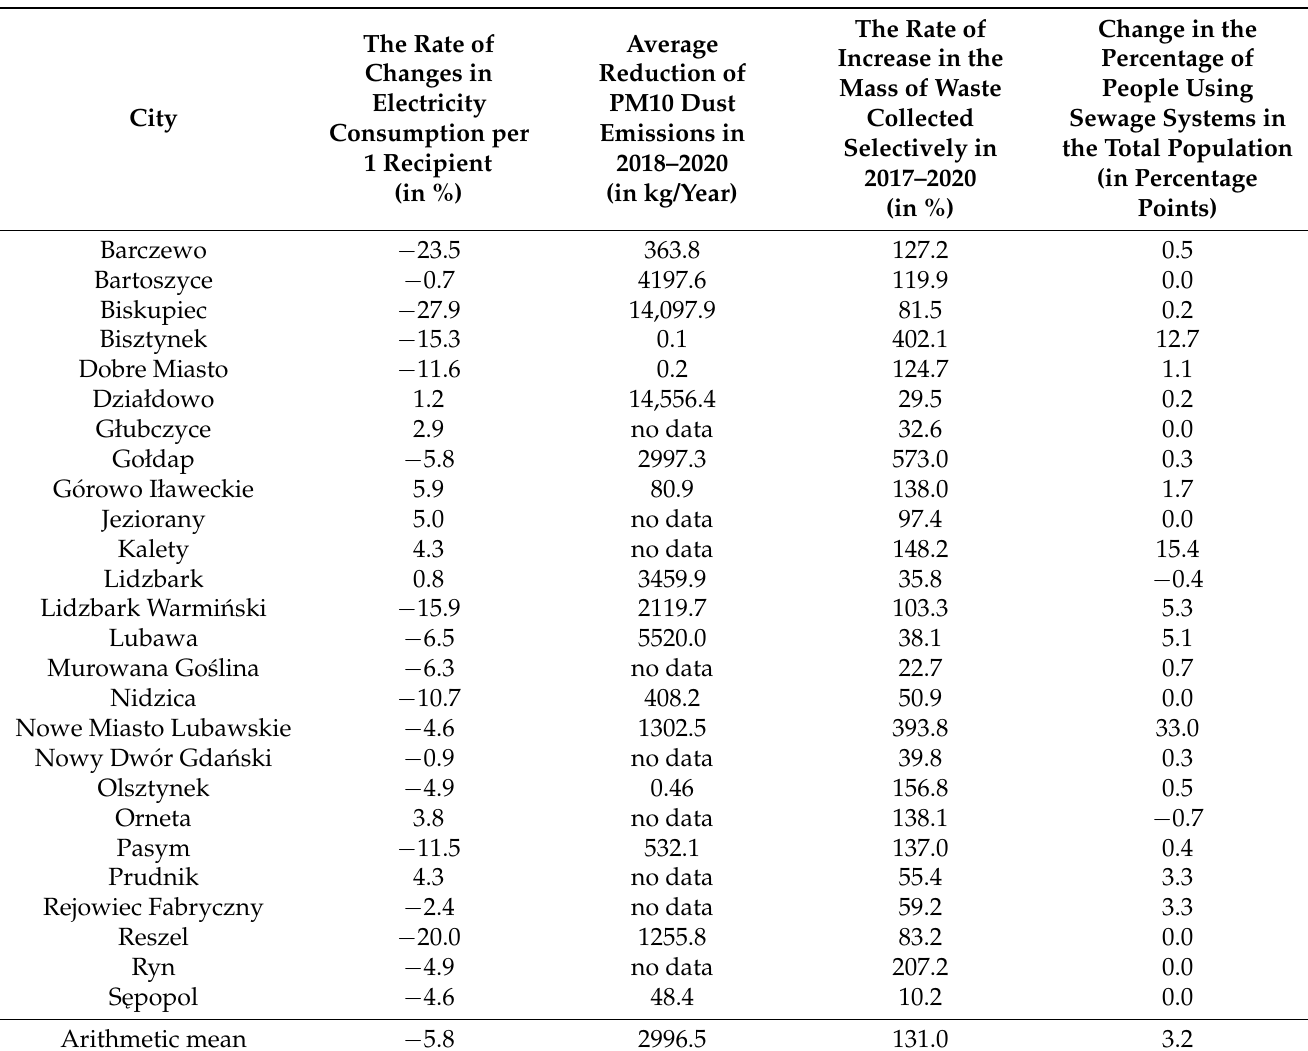
Table 5. The effects of activities undertaken by Polish slow cities in the area of “energy and environ- mental